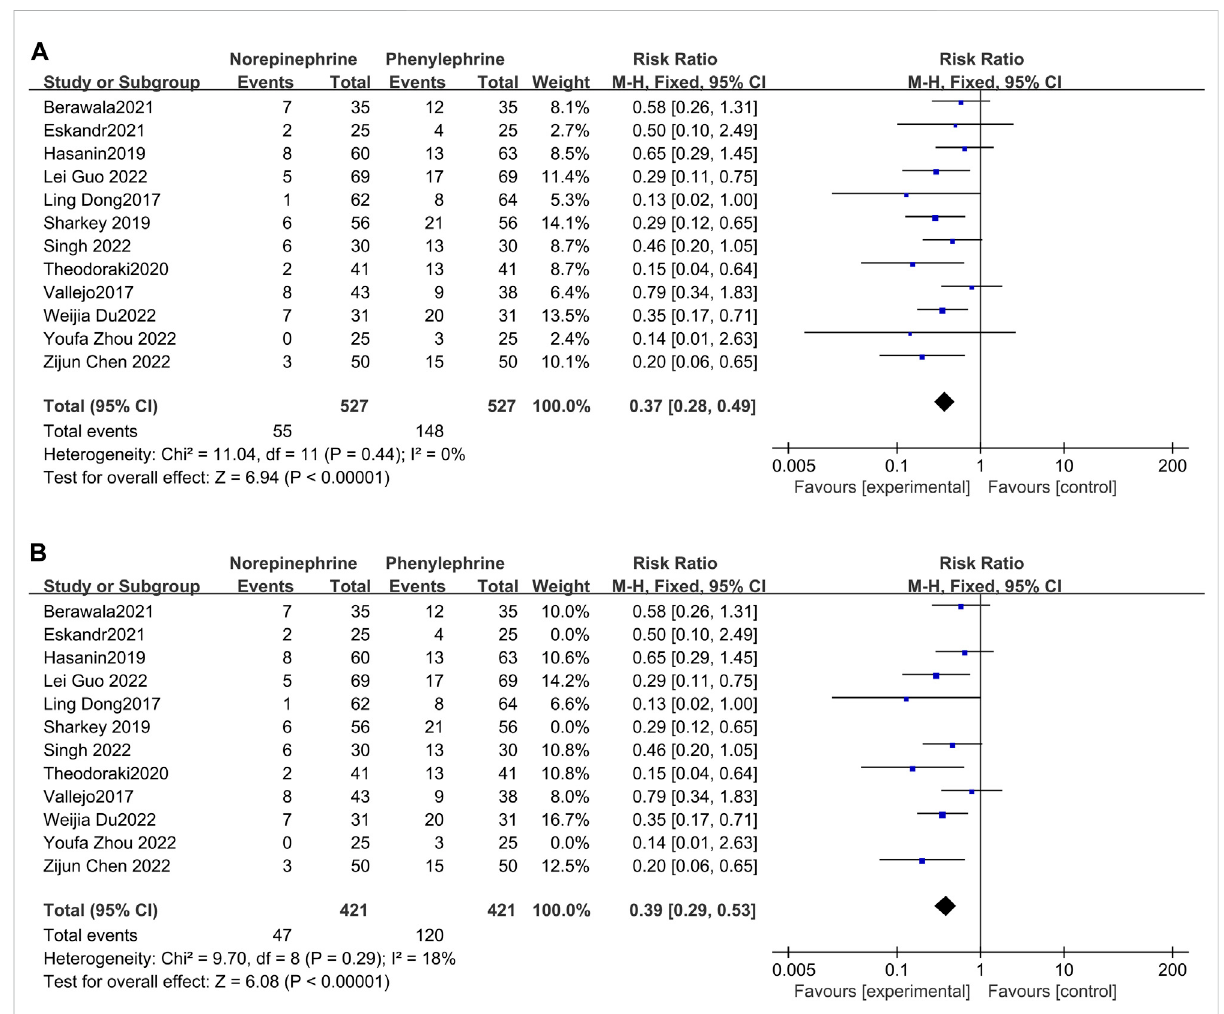
FIGURE 3 Forest plot of the incidence of bradycardia comparing norepinephrine with phenylephrine. (A) Analysis before exclusion. (B) Analysis after exclusion.